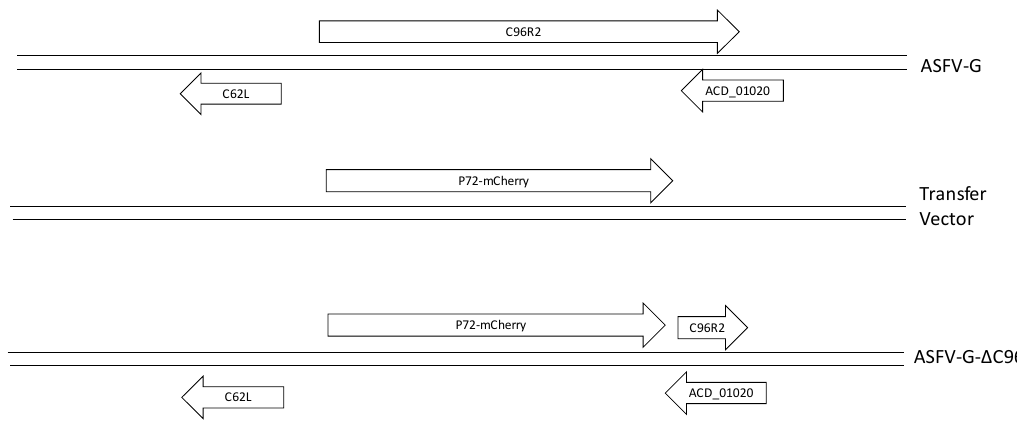
Figure 3 . Schematic for the development of ASFV-G- Δ C962R. The transfer vector contains the p72 promoter and a mCherry cassette; the flanking left and right arms are indicated and were designed to have flanking ends to both sides of the deletion/insertion cassette. The resulting ASFV-G- Δ C962R virus with the cassette inserted is shown on the bottom.